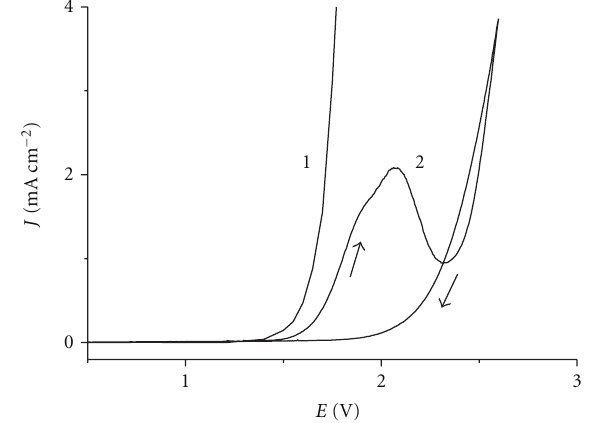
Figure 2: Cyclic voltammograms in 1M KCl solution: (1) benzene- free solution, (2) benzene-saturated solution. Potential scan rate